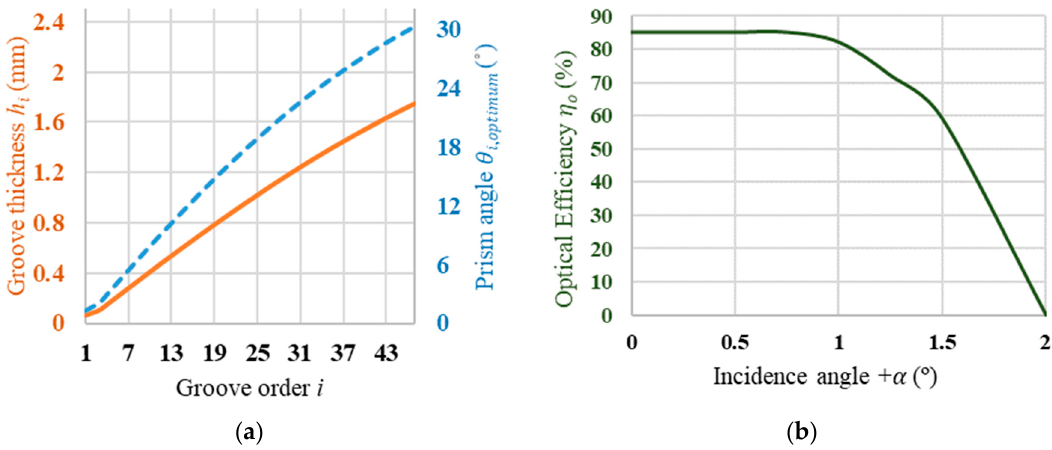
Figure 5. For Case 1: ( a ) prism angles (dashed blue line) and groove thickness (solid orange line) of the optimum Fresnel lens POE and ( b ) the concentrator’s optical e ffi ciency (POE + SOE) at di ff erent incidence